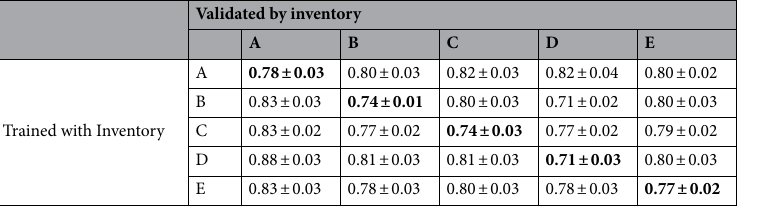
Table 4. Pairwise validation among five inventories in the overlapping area. The table presents the mean with one standard deviation confidence level for the AUC ROC obtained from each testing/validating pair, with 20-fold random selection.